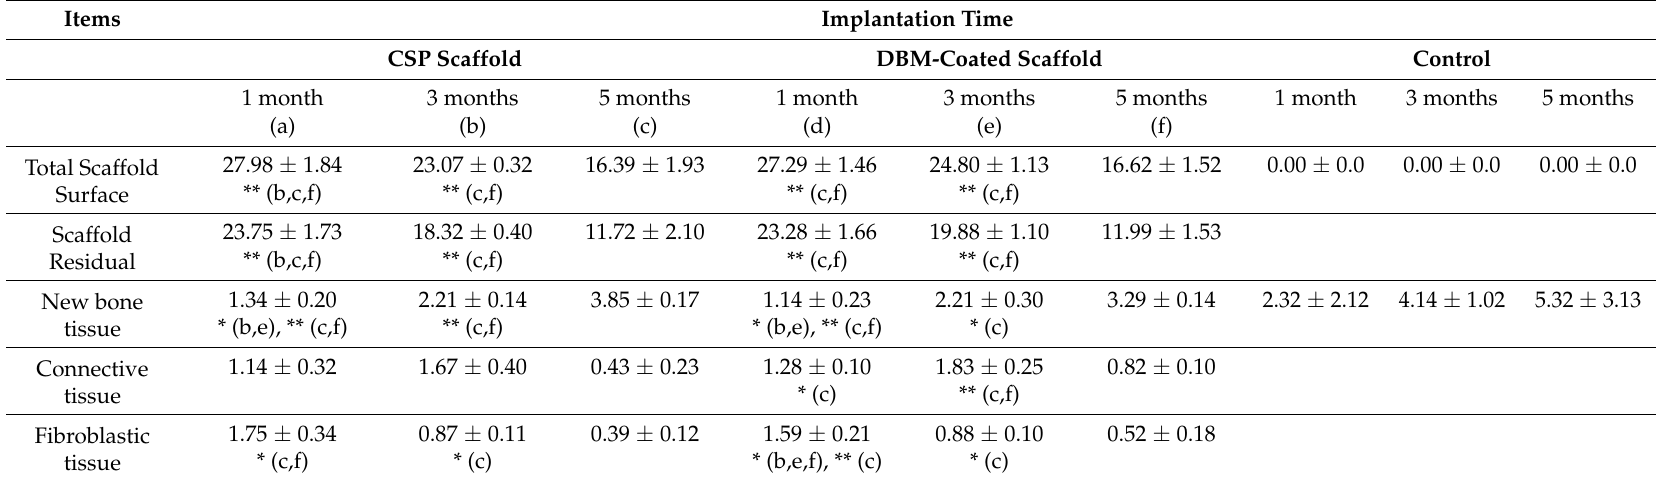
Table 1. Histomorphometric analysis for the biphasic scaffold (micrometers 2